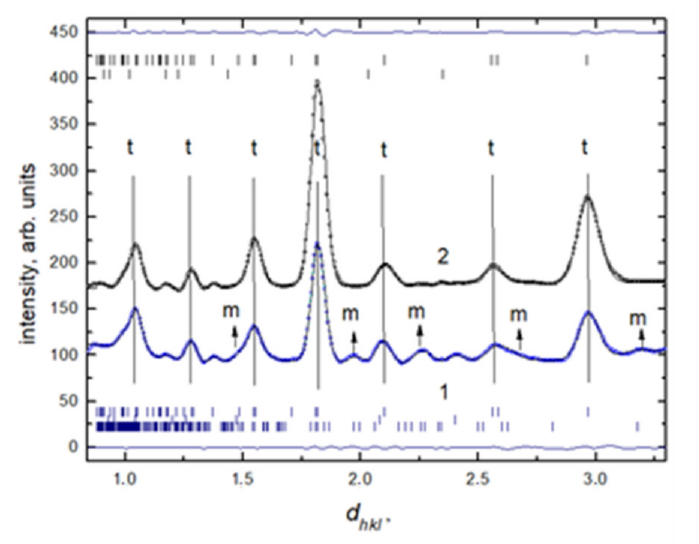
Figure 2. Neutron diffraction patterns of dry (black line, 2) and hydrated (blue line, 1) ZrO 2 + 3 mol% Y 2 O 3